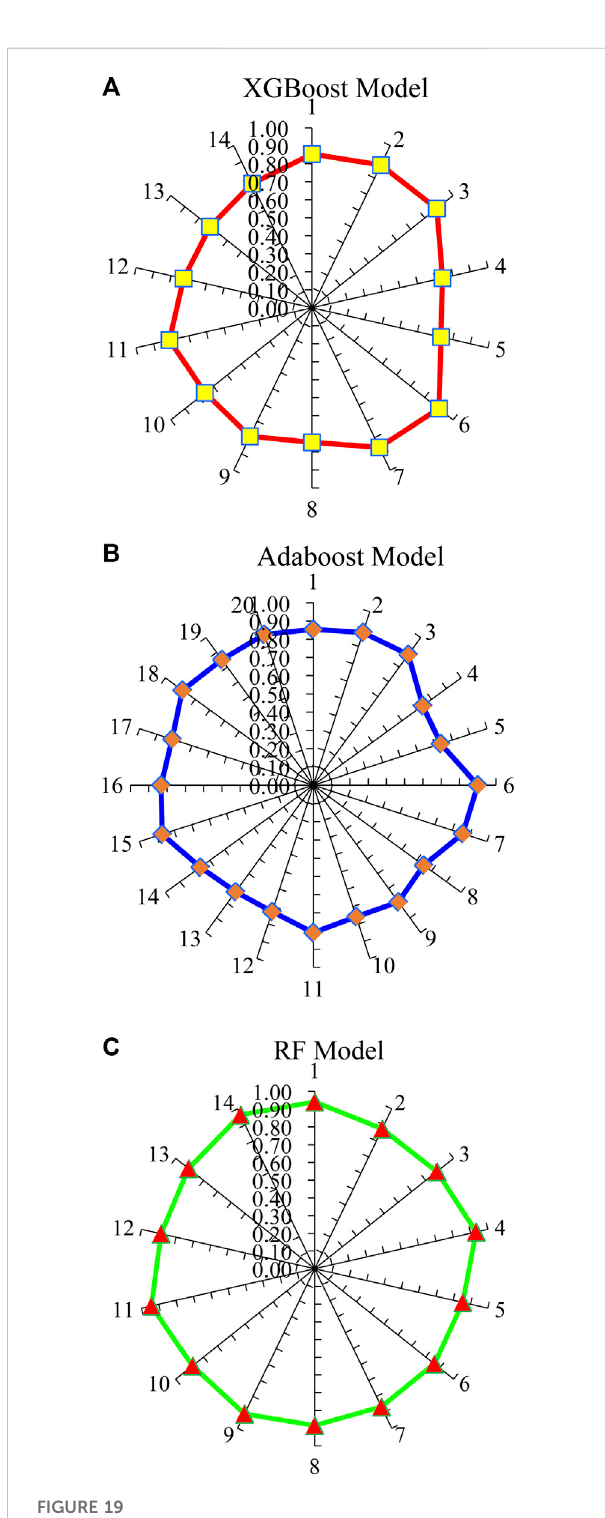
FIGURE 19 Results of sub-models: (A) XGBoost; (B) Adaboost; (C)